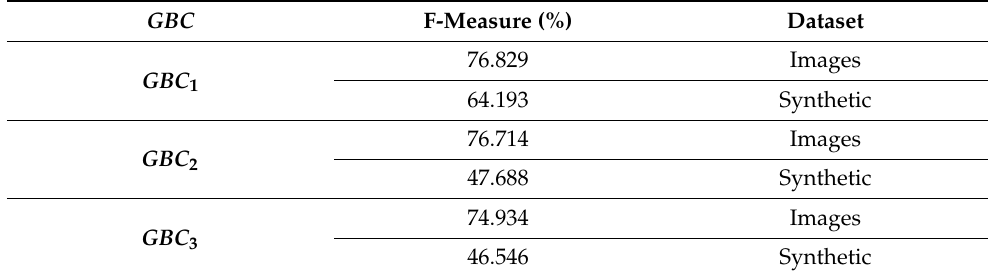
Table 1. F-measures of the first three